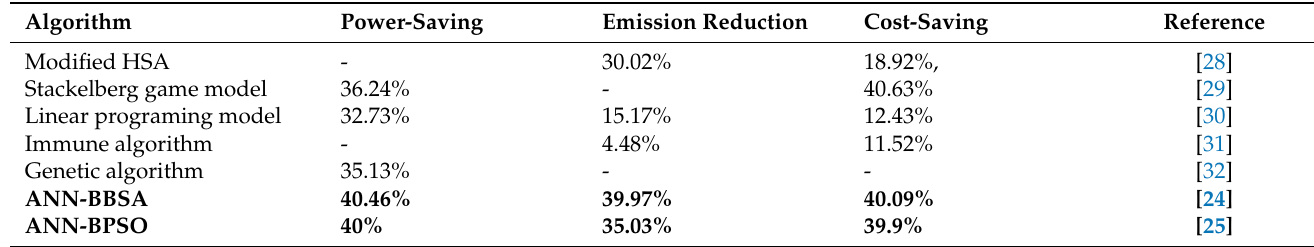
Table 11. Comparative analysis of the developed algorithms with other methods.